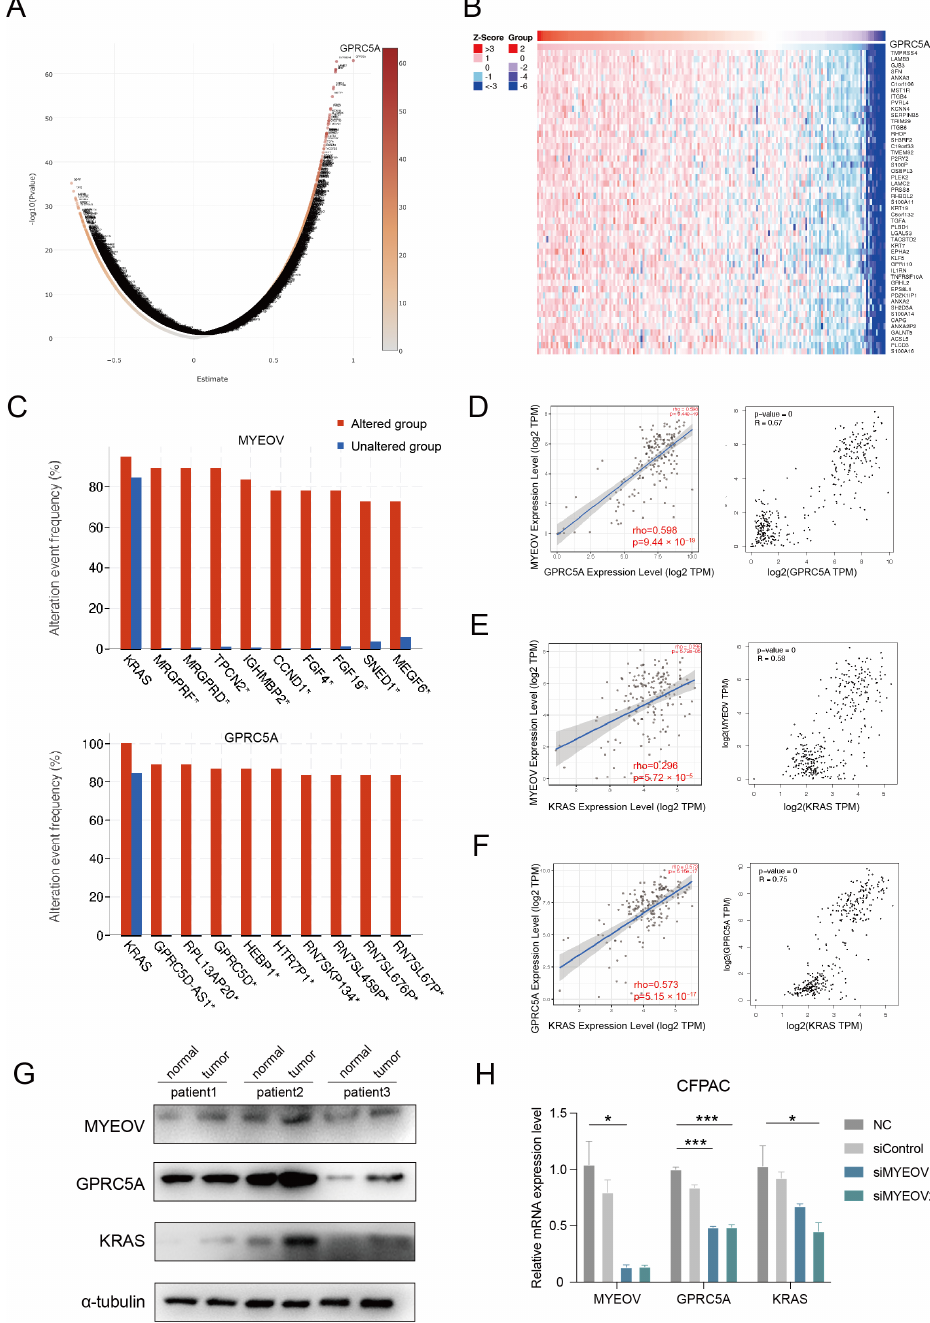
Figure 2. Gene co-expression analysis of MYEOV in pancreatic cancer. ( A ) Volcano map of genes obtained from MYEOV co-expression analysis. ( B ) Heat map of positively correlated genes from MYEOV co-expression analysis. ( C ) Alteration-associated gene predictions for MYEOV and GPRC5A, respectively, by the cBioPortal database. ( D ) There was a strong positive association be- tween MYEOV and GPRC5A. ( E ) There was a strong positive association between MYEOV and KRAS. ( F ) There was a significant positive association between GPRC5A and KRAS. ( G ) Protein expression levels of MYEOV, GPRC5A, and KRAS in pancreatic cancer tissues and normal tissues adjacent to pancreatic cancer from three pancreatic cancer patients were detected by western blot- ting. ( H ) Changes in mRNA levels of MYEOV, GPRC5A, and KRAS after knockdown of MYEOV with siRNAs in CFPAC cells. * p < 0.05, *** p < 0.001.